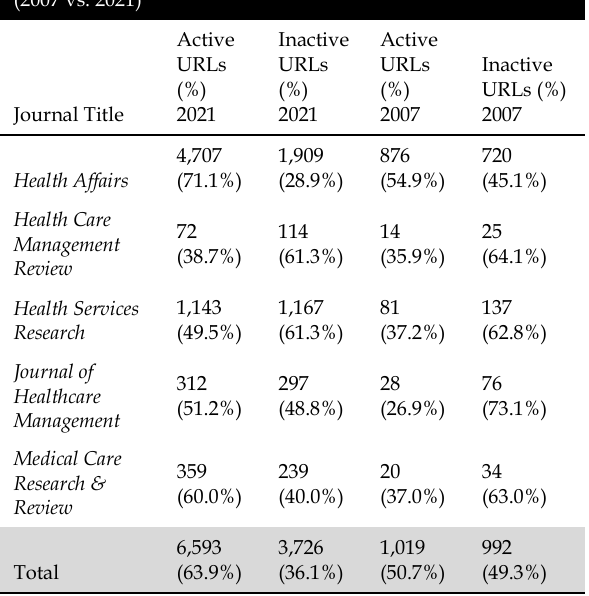
Table 5: Number and Percentage of active and inactive URLs by journal title (2007 vs. 2021)